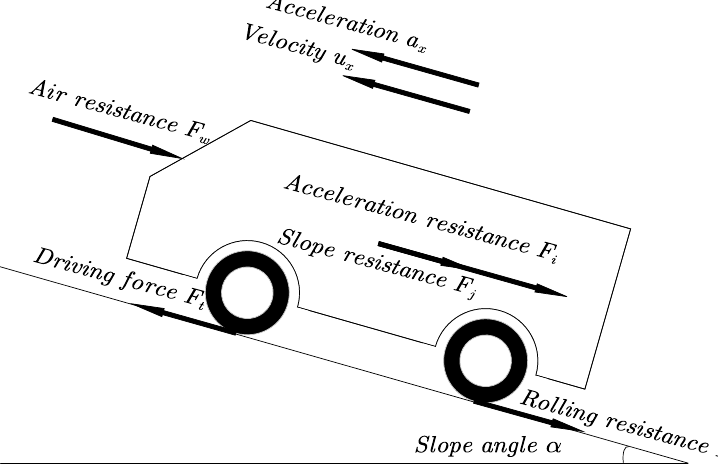
Figure 3. The force analysis of a vehicle moving on a slope.